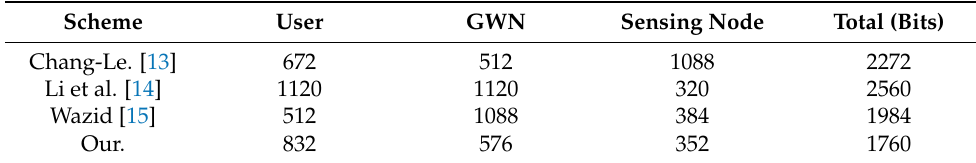
Table 3. Communication Cost